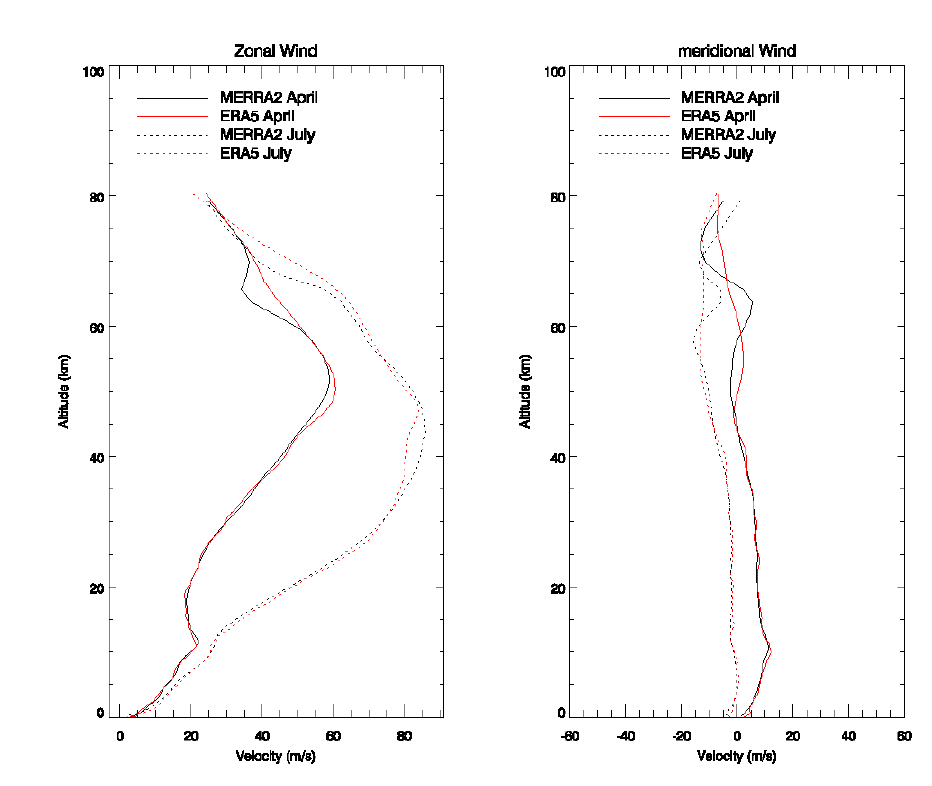
Figure 3. Monthly averaged winds for April (continuous lines) and July (dotted lines) of 2017, at 00:00 UT, obtained by ERA-5 (red) and MERRA-2 (black) reanalysis, for 62 ◦ S and 58 ◦ W. Horizontal wind ( v ) can be represented by the zonal ( v z ) and meridional ( v m ) wind components as a function of the azimuth ( φ